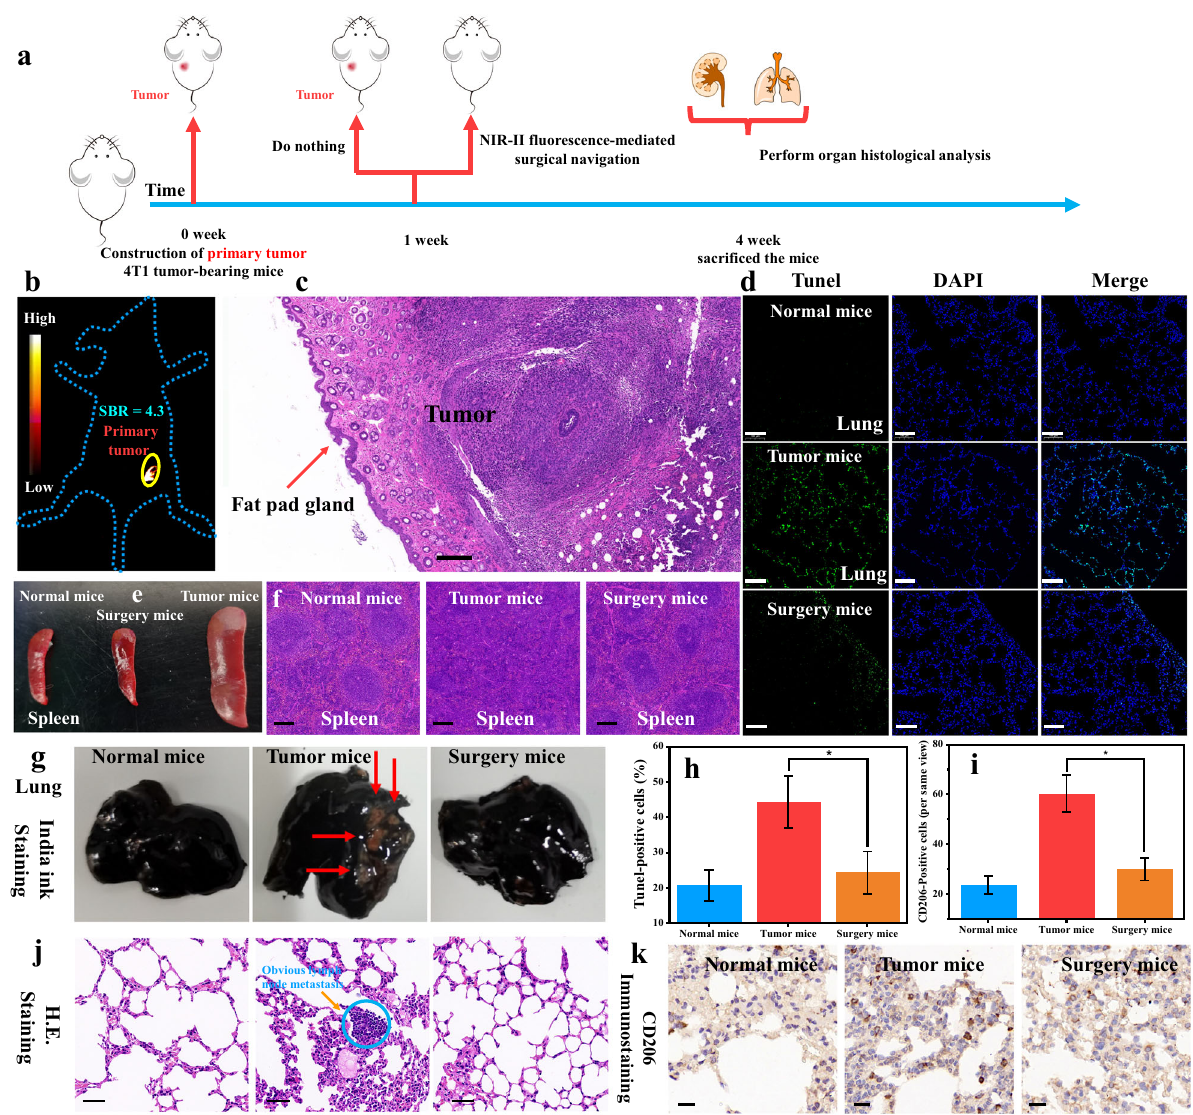
Fig.7|Surgicalnavigationforaprimarybreasttumorandassessmentoftumor metastasis.a